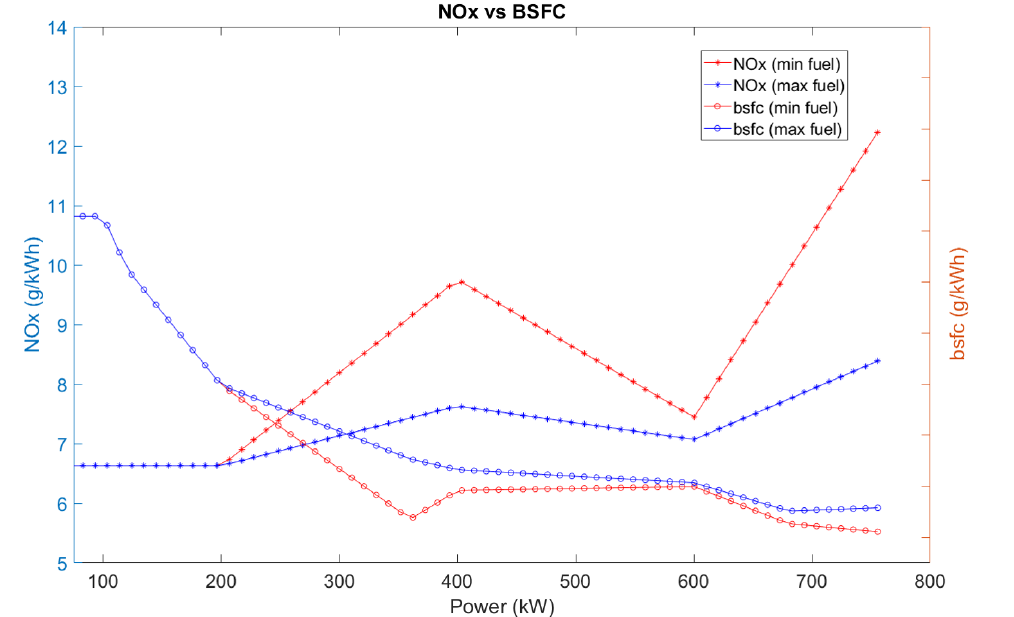
Figure 12. Demonstration of the trade-off between the BSFC and NO x